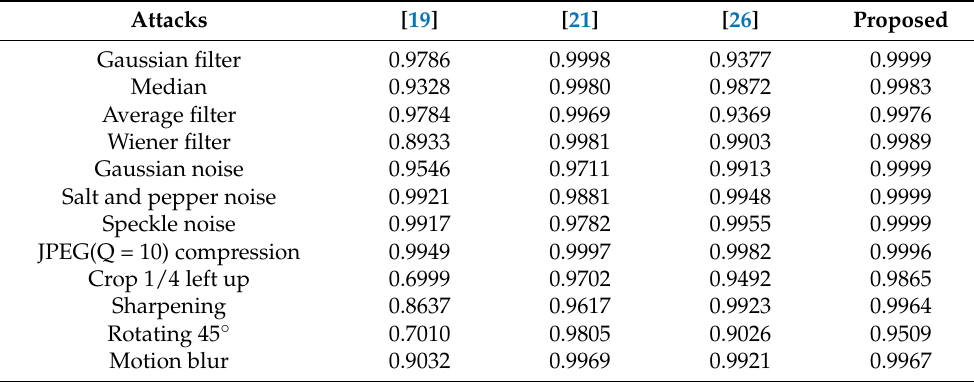
Table 6. NC values of different algorithms under